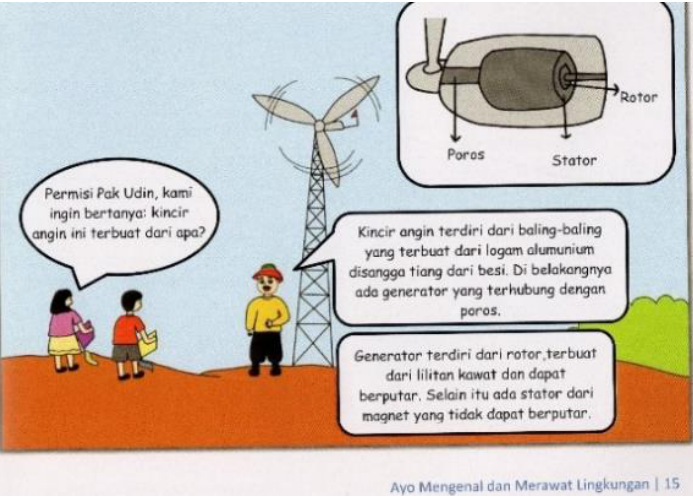
Figure 1 : An example of the pictorial stories